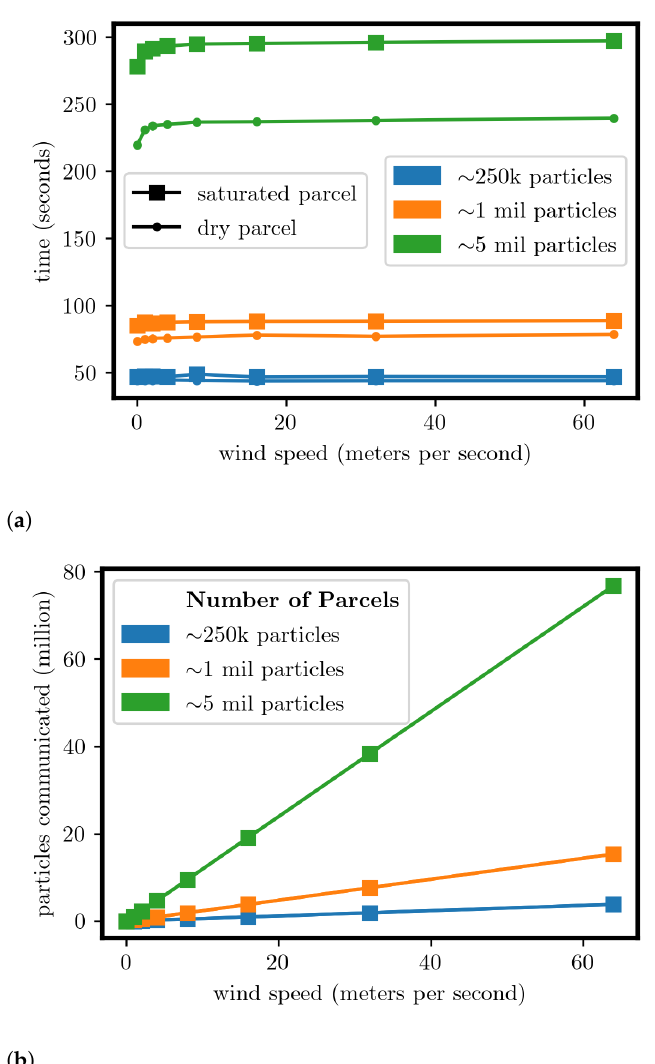
Figure 12. On a Cray machine. ( a ) The effects of wind speed with varying particle count using dry and saturated particles. ( b ) The number of total particles communicated with the change in